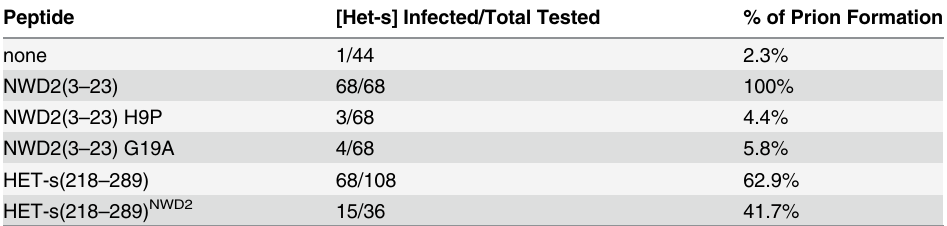
Table 2. Transfection of [Hets * ] strains with wild-type and mutant NWD2(3 – 23) peptides. Peptide